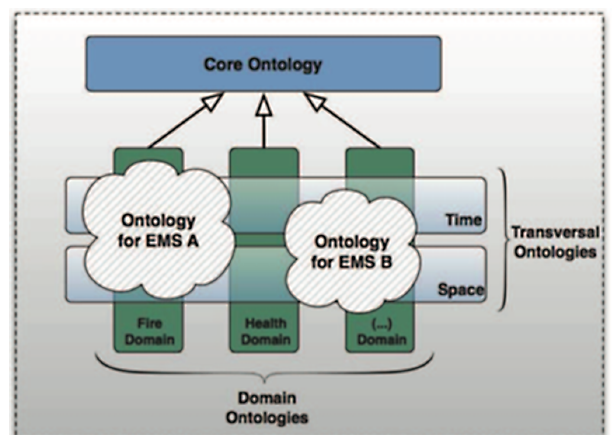
Figure 2. High-level overview of the EMERGEL components, their transverval modules to be used in any domain and domain-specific modules (e.g.